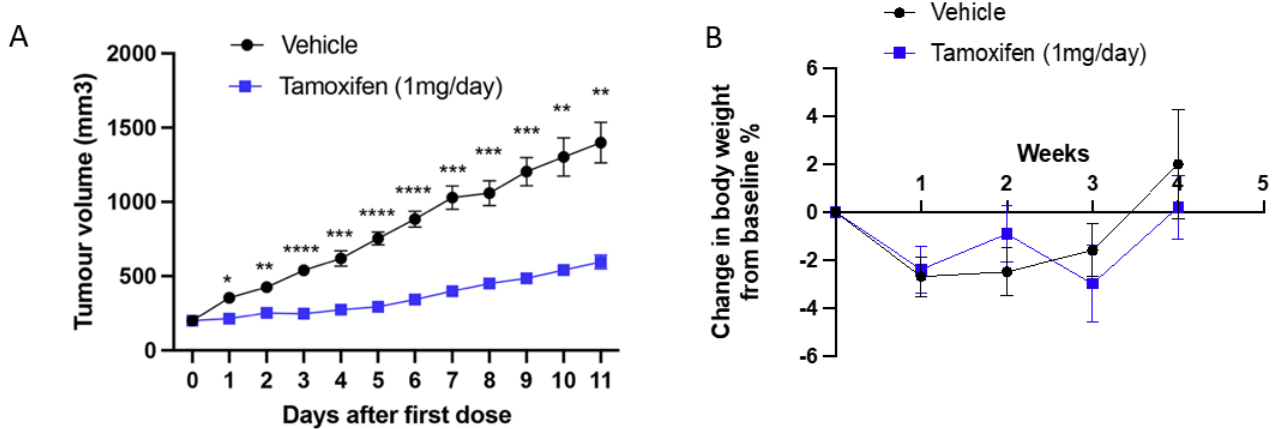
Figure 4. Response of SSM3 cell line to tamoxifen in vivo . ( A ) SSM3 tumour growth over time in tamoxifen-treated vs vehicle control-treated 129SvEv mice. 129SvEv mice inoculated with 100,000 SSM3 ER + tumour cells and treated daily with vehicle control ( n = 10) or 1 mg tamoxifen citrate ( n = 7) once tumours reached 200 mm 3 . ( B ) Change in body weight from baseline of mice injected with SSM3 cells and treated with tamoxifen compared to vehicle. Data are presented as mean ± SEM. Data were analysed with a mixed-effects two- way ANOVA and Sidak’s multiple comparisons test. **** p ≤ 0.0001, *** p ≤ 0.001, ** p ≤ 0.01, * p ≤ 0.05.